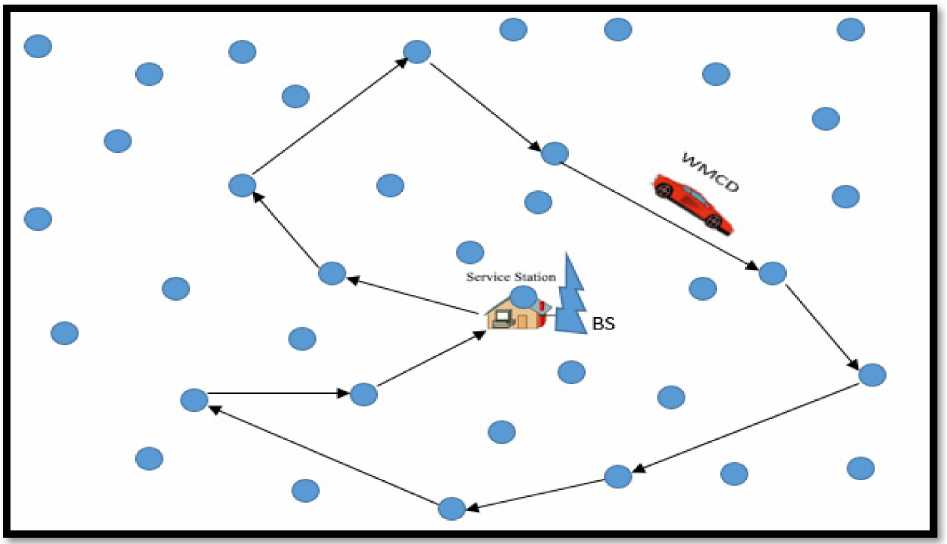
Figure 1. A WSN with a wireless mobile charging device. The WMCD must visit and charge some sensor nodes during each cycle (C). H n denotes the group of nodes that must be visited in the Cth cycle. WMCD goes through the smallest Hamiltonian cycle that joins all nodes in H n and the RS in the Cth cycle. P n represents the shortest Hamiltonian cycle’s traveling path. D n denotes the length of path P n , and t n denotes the time spent traveling across distance D n